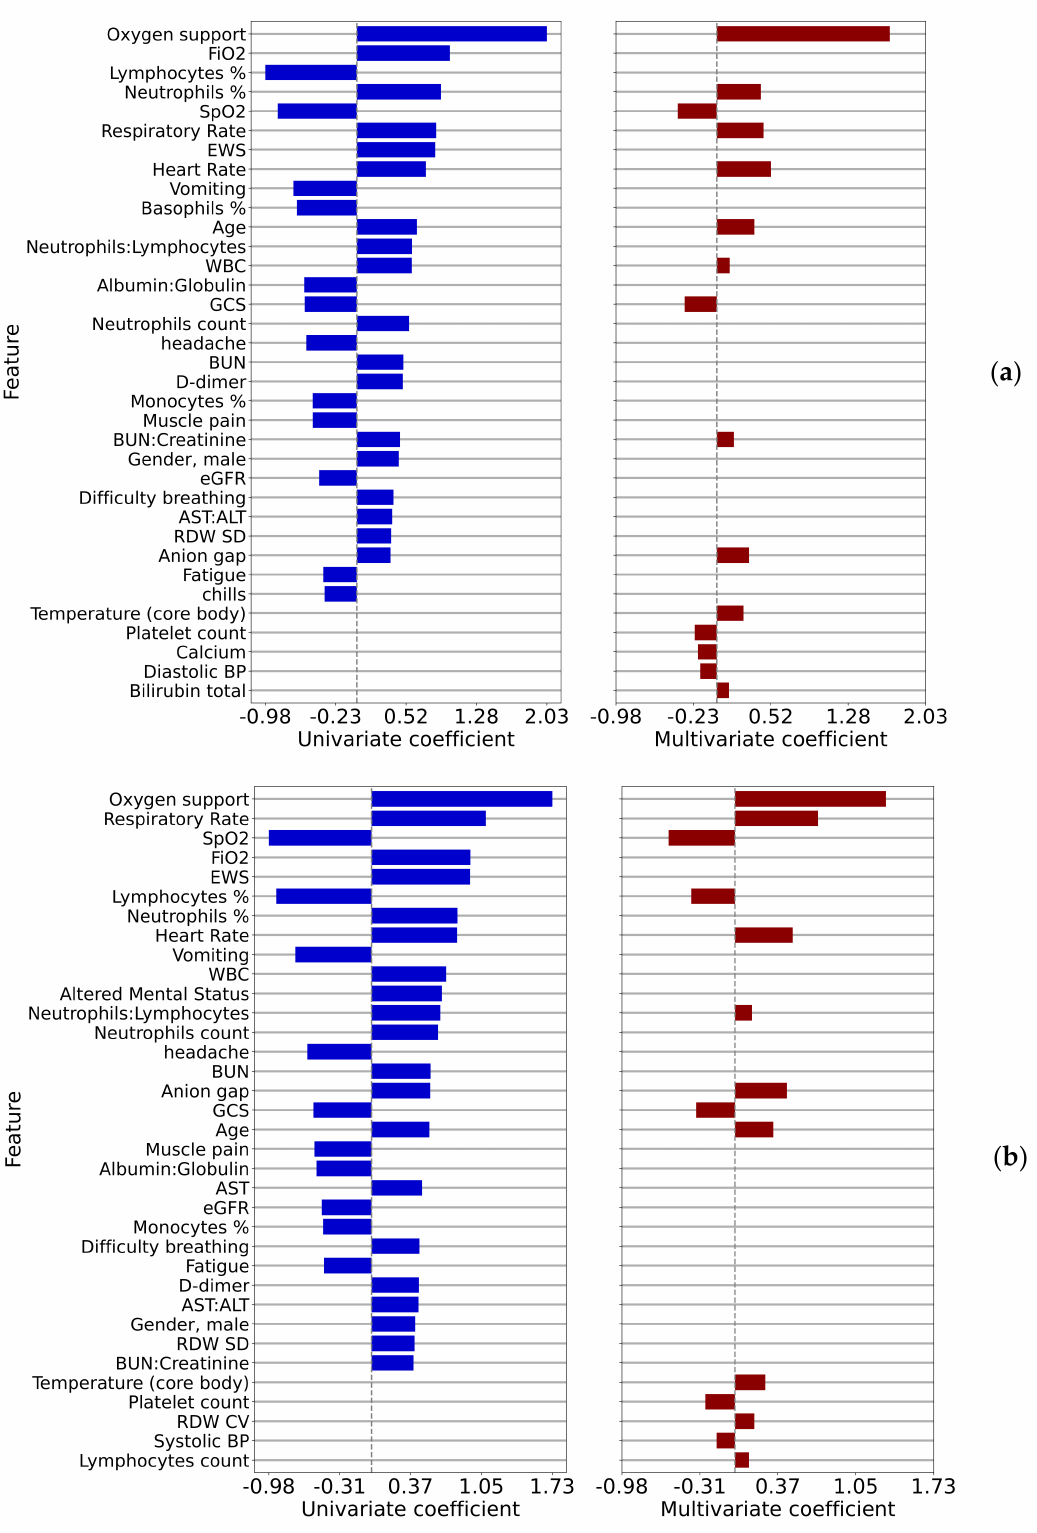
Figure 4. Univariate and multivariate regression coefficients for comparison 3 ( a ) 12 h prior to the event and ( b ) 4 h prior to the